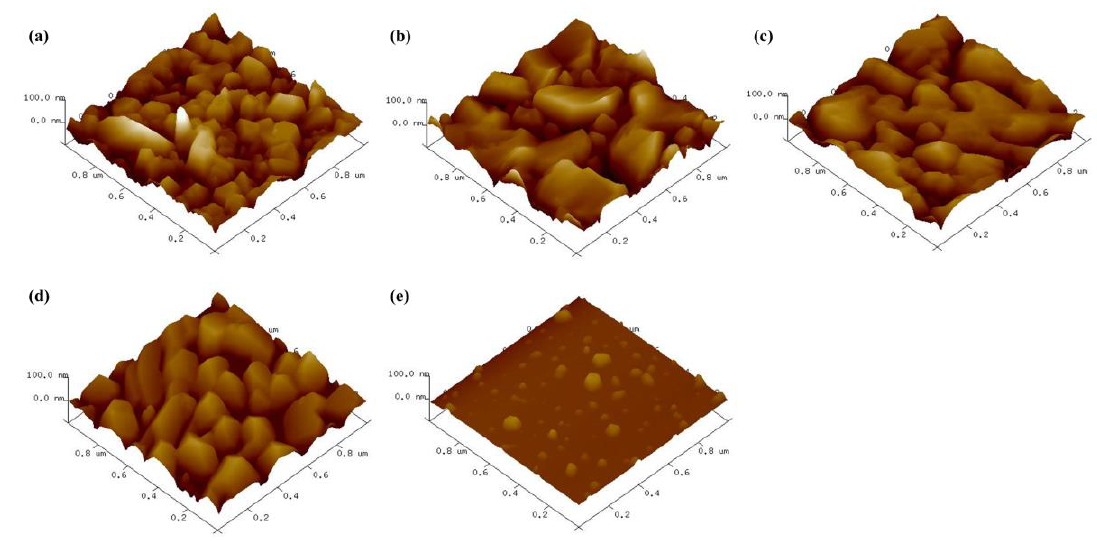
Figure 4. Atomic force microscopy (AFM) images of deposited catalyst particles with various R values: ( a ) R = 0, ( b ) R = 0.17, ( c ) R = 0.3, ( d ) R = 0.5, and ( e ) R = 0.67.